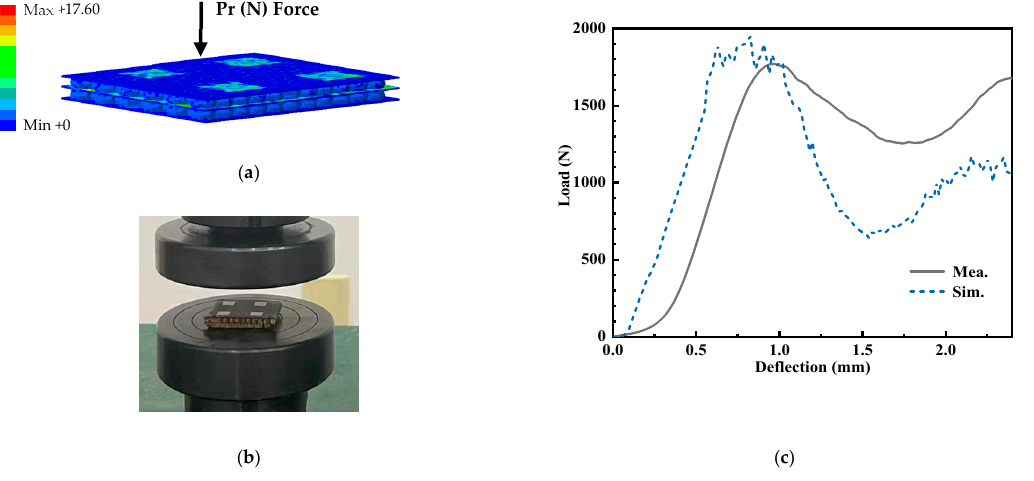
Figure 20. The quasi-static compression test of double-layer honeycomb sandwich panel, ( a ) simulation model ( b ) experiment environment, and ( c ) load–deflection relationships.